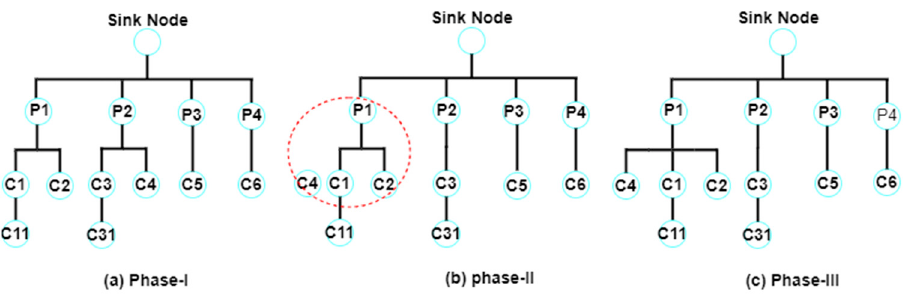
Figure 20. Execution steps of M-ATTEMPT protocol